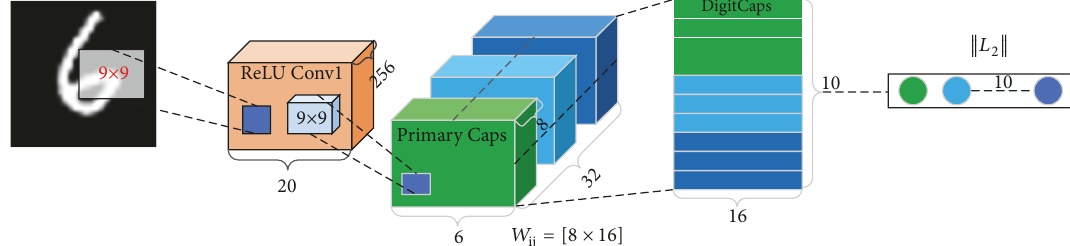
Figure 1: Three-layer capsule neural network.